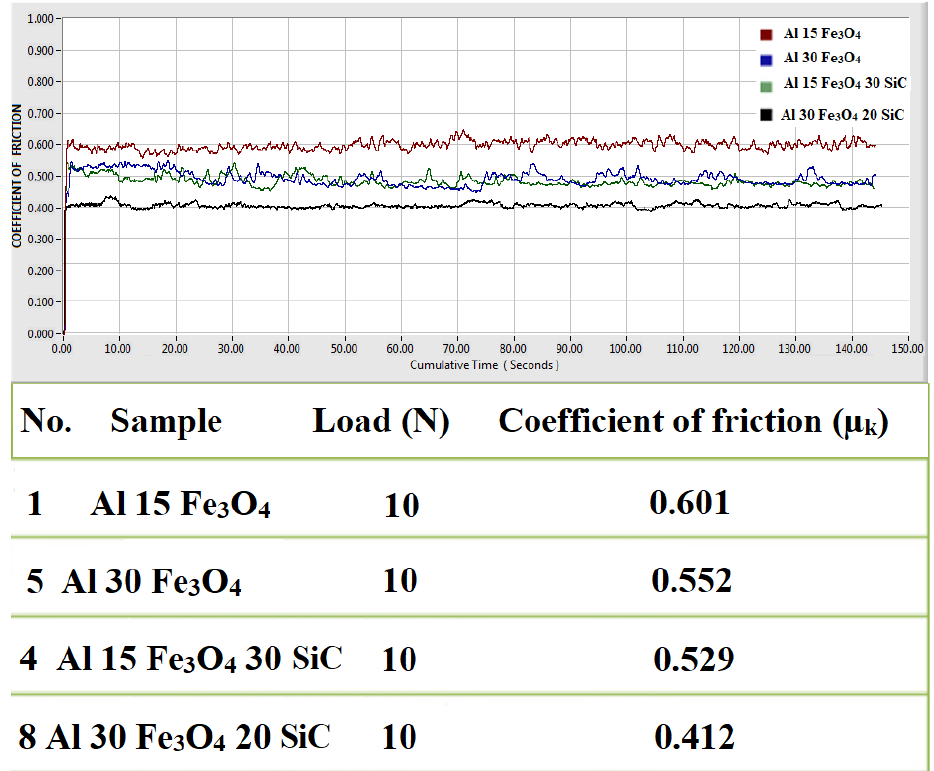
Figure 10. The coefficient of friction (COF) vs. cumulative sliding time for the Al - 15 Fe 3 O 4 , Al - 15Fe 3 O 4 - Figure 10. The coe ffi cient of friction (COF) vs. cumulative sliding time for the Al-15 Fe 3 O 4 30SiC, Al - 30Fe 3 O 4 , and Al - 30Fe 3 O 4 - 20SiC specimen.